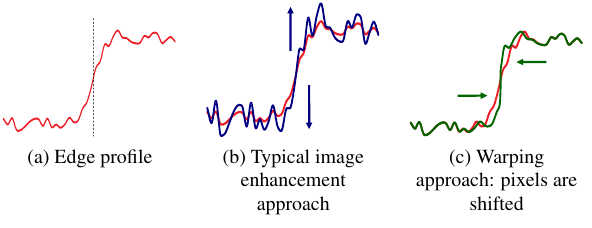
Figure 1. The idea of edge sharpening by grid